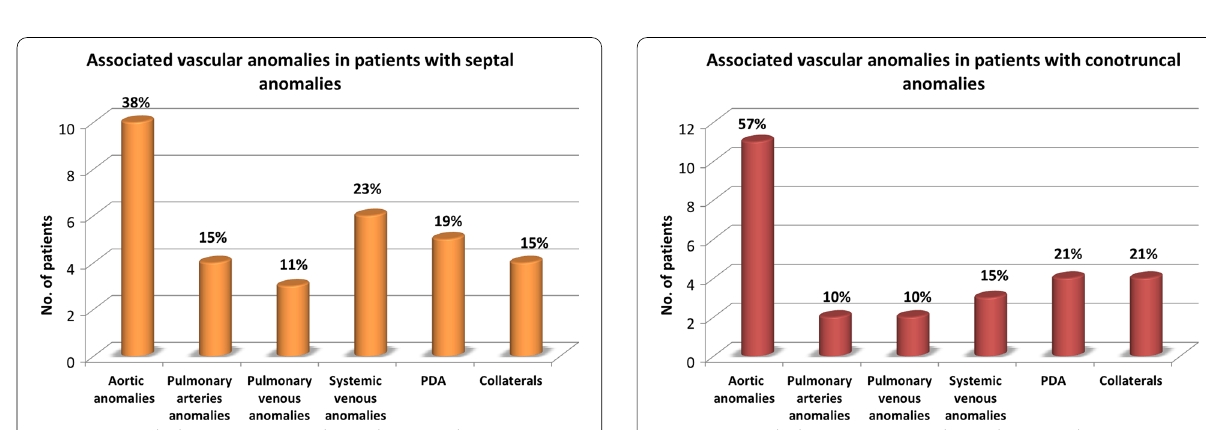
Fig. 2 Bar graph showing associated vascular anomalies in patients with septal anomalies